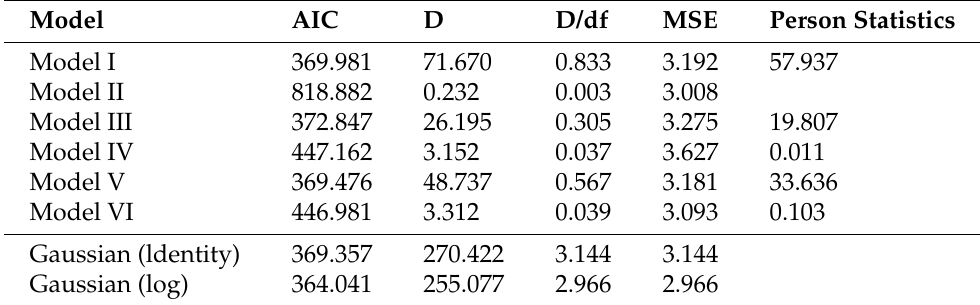
Table 5. Efficiency Gaussian, inverted Wiebull (IW-Reg), IW-Bayesian regression (IW-BReg) models.